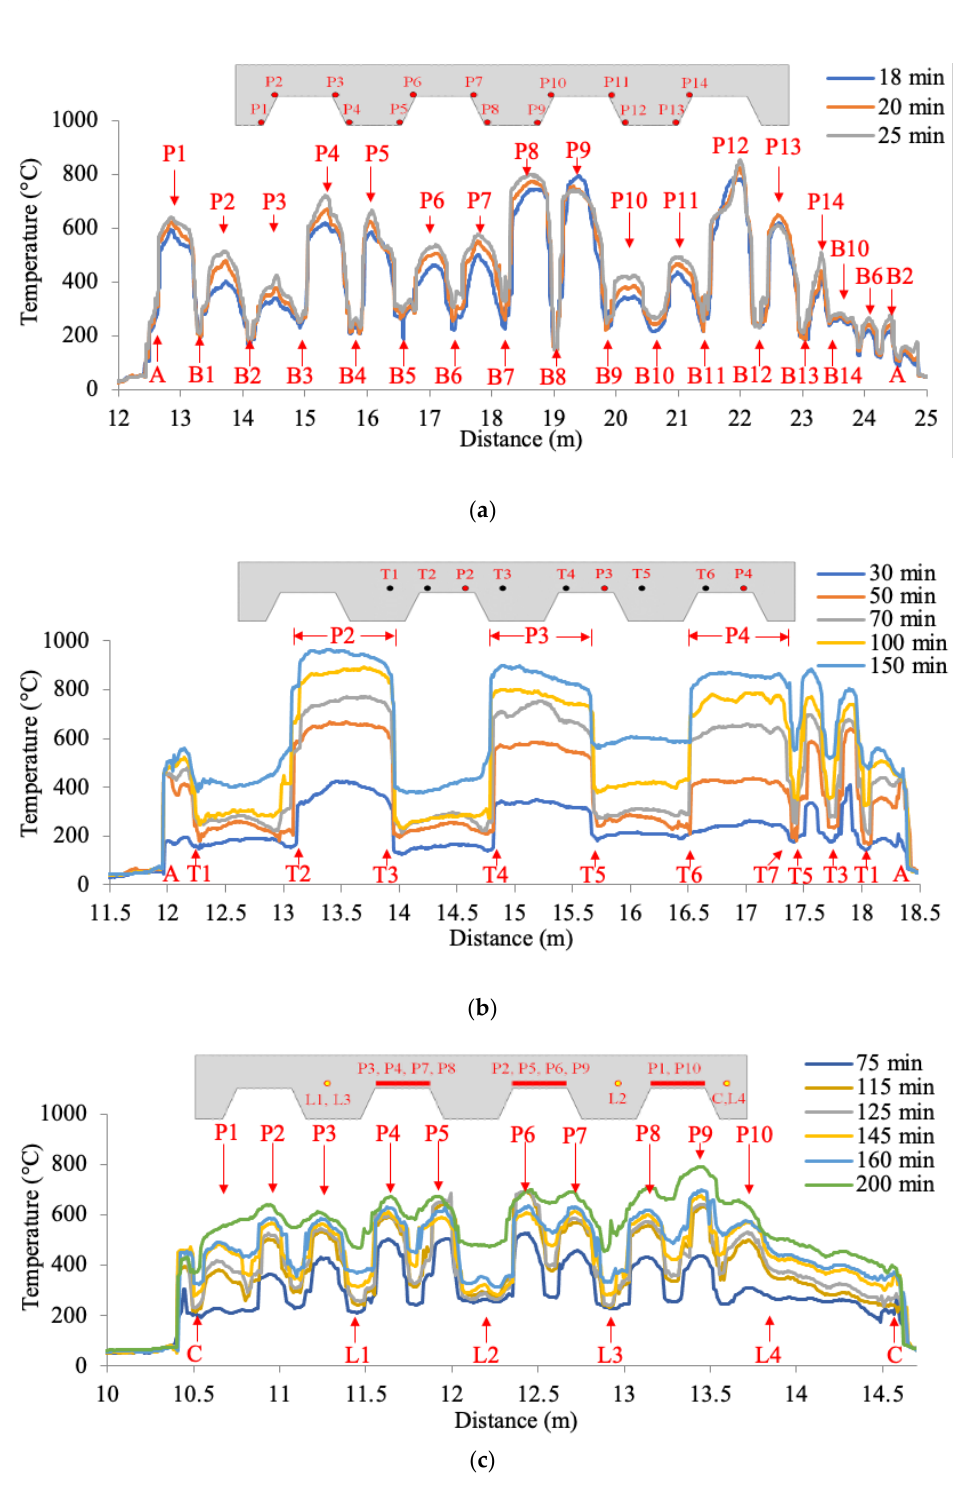
Figure 7. Temperature distributions measured from the distributed sensors in specimen CS-1: ( a ) DFOS-1, ( b ) DFOS-2, and ( c ) DFOS-3. The peaks in slab illustration and test results are marked as “Pn”, where “n” indicates the location of a peak (see Figure 3).